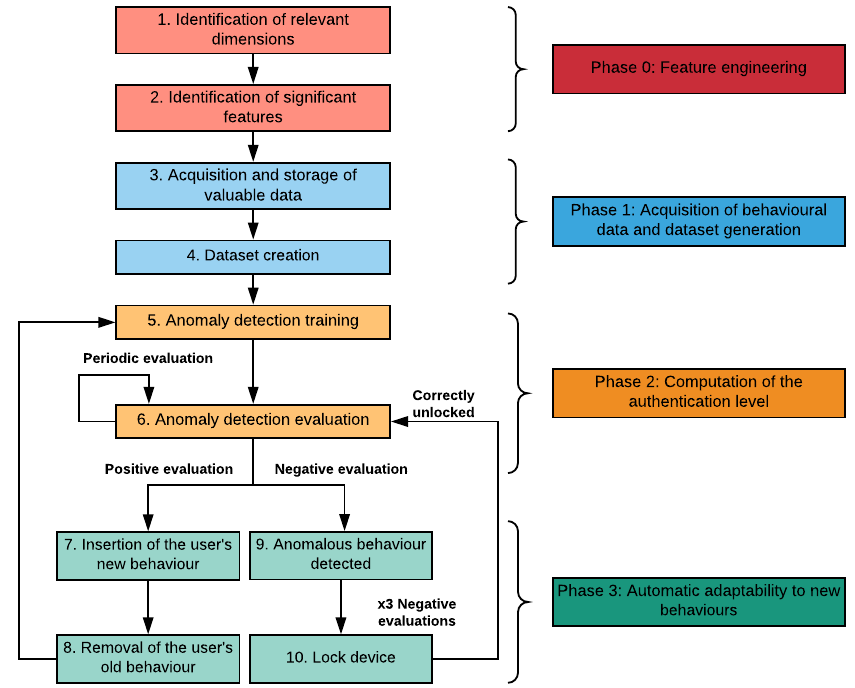
Figure 1. Phases and processes of the proposed adaptive and continuous authentication